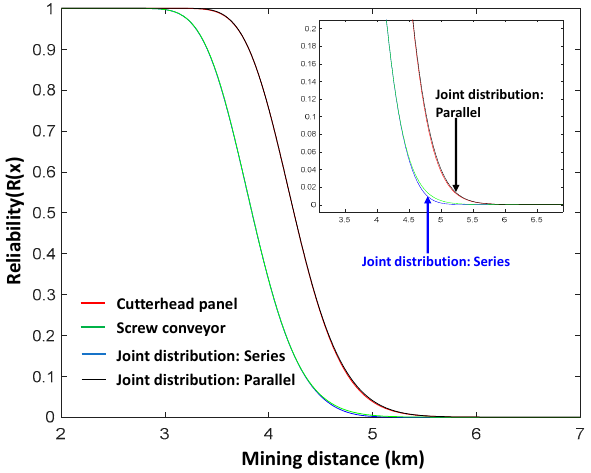
Figure 9. Joint distribution of the reliability function with serial or parallel failure modes.